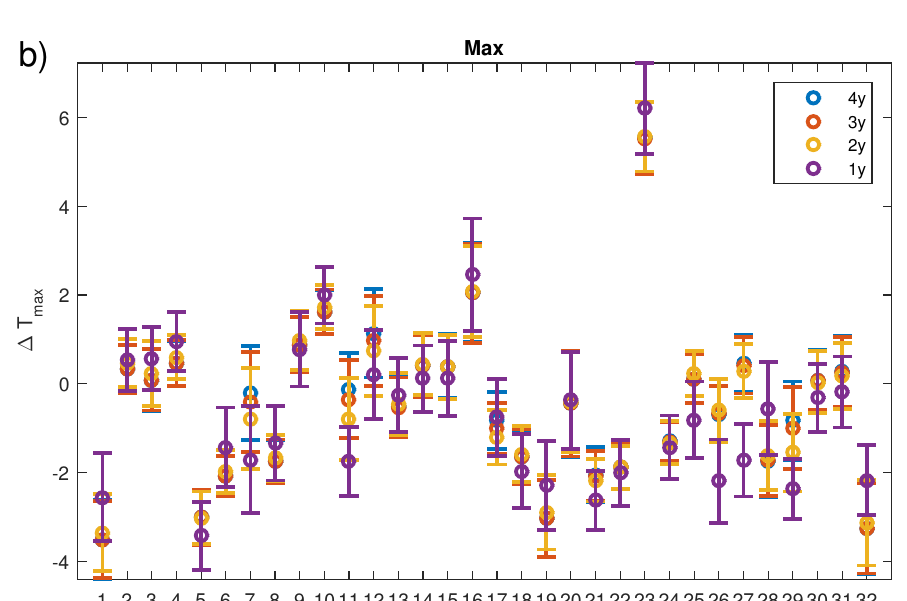
Figure 4. Errorbars of the biases in ( a ) T min and ( b ) T max between models and 20CRv2c in 1900–1999. Errorbars correspond to the standard deviation of the mean. Different bin length m are represented: 1 year in blue, 2 years in orange, 3 years in yellow and 4 years in purple. Detailed statistical information about this figure appear in Table